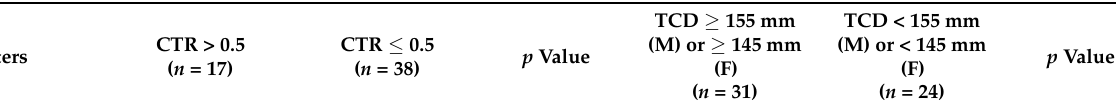
Table 2. Baseline characteristics of the patients with normal and increased chest radiograph indicators of cardiac size